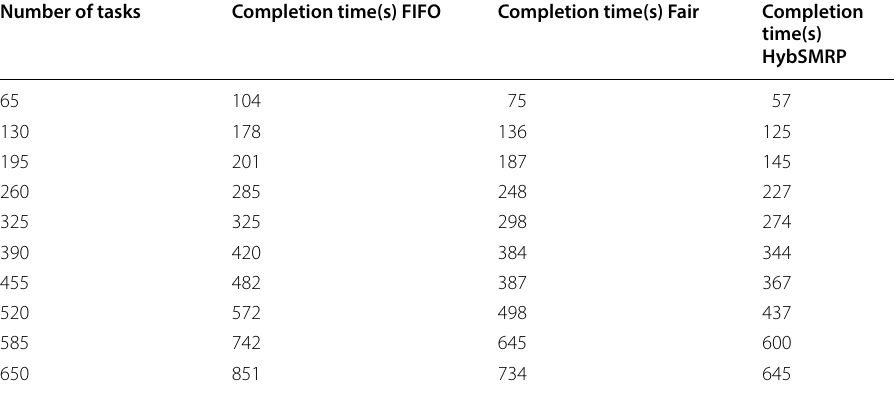
Table 7 Numerical comparison of HybSMRP with FIFO and Fair schedulers based on completion time on Terasort Number of